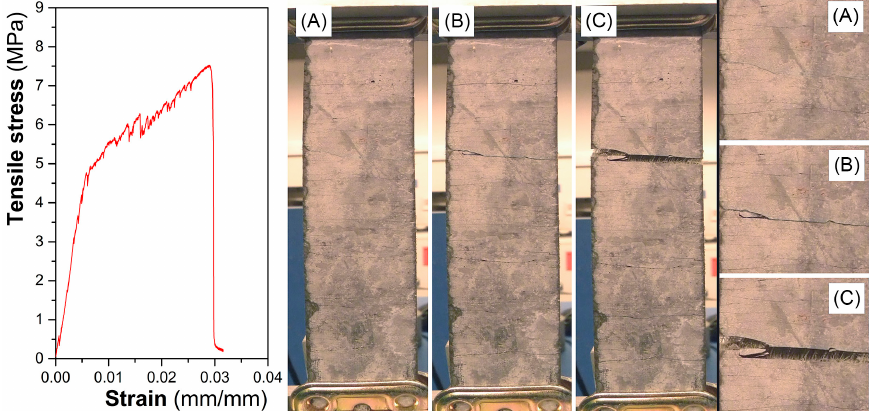
Figure 4. Representative curve and cracking phases of the composites obtained under tensile stress: ( A ) first crack; ( B ) generation of new cracks; ( C ) increase of crack length.